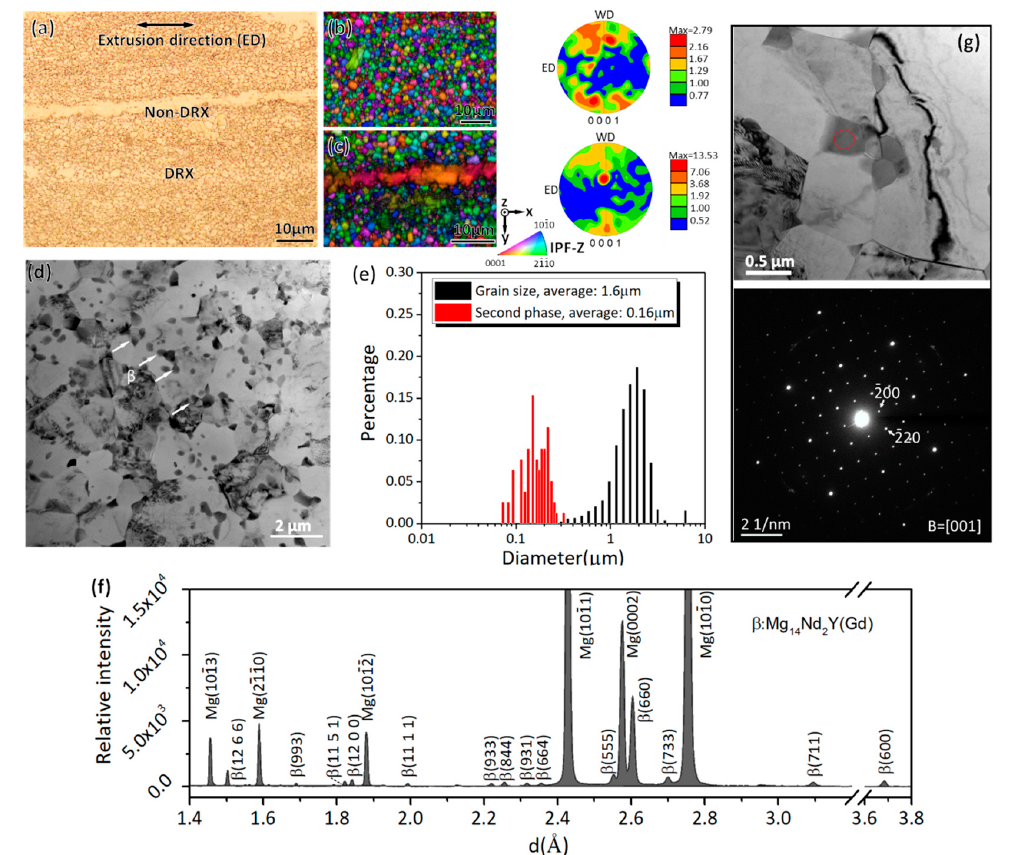
Figure 2. Microstructures of the hot-extruded WE54 alloy. ( a ) Optical micrograph; ( b , c ) IPF-Z maps coupled with image quality (IQ) showing the texture of the recrystallized grains and the elongated grains; ( d ) TEM image showing the distribution of the second phases in the matrix; ( e ) size distribution of the second phases and recrystallized α -Mg grains; ( f ) X-ray line profile where the diffraction peaks from the α -Mg and β -Mg 14 Nd 2 Y(Gd) were identified; ( g ) SAED results from the precipitate (see circled area) in the TEM bright field image.